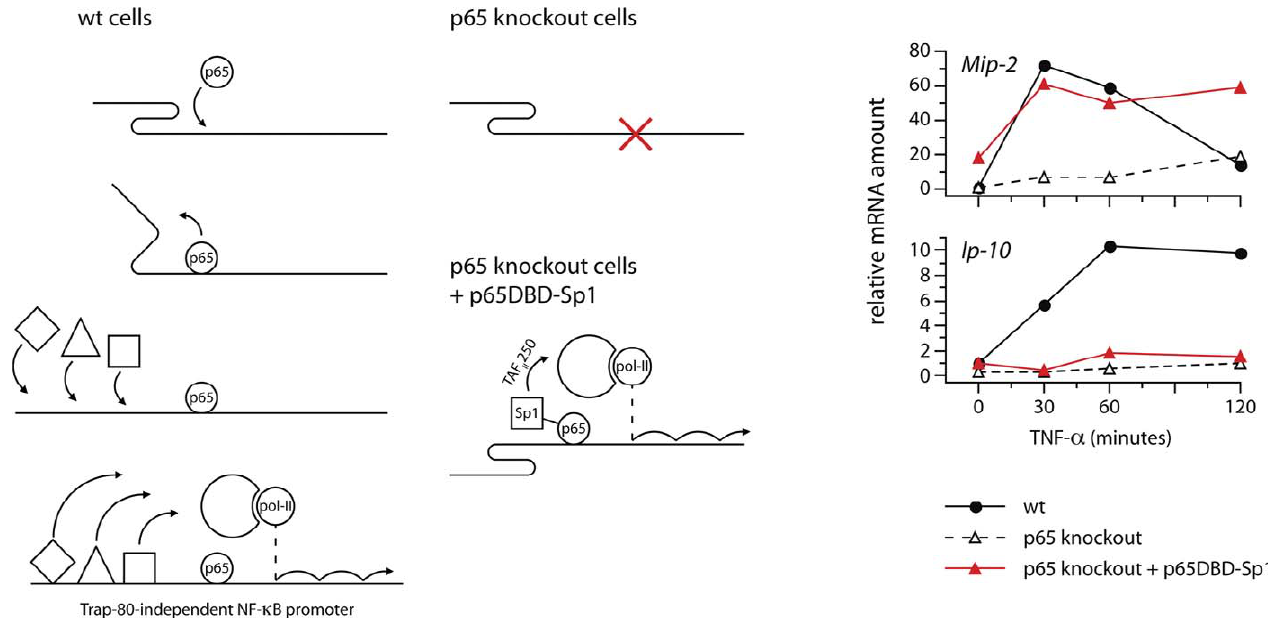
Figure 7. An Artificially Recruited Secondary Transcription Factor Drives Transcription in the Absence of p65 On the left is a cartoon illustrating our model for the events occurring at Trap-80–independent promoters. In wild-type cells, initial p65 binding brings about an undefined change to target promoters, which allows the binding of various secondary transcription factors. Once bound, these can drive the recruitment of pol-II, and so enable transcription. In p65-knockout cells, secondary transcription factors cannot bind and no transcription takes place. If binding of a secondary transcription factor is artificially restored (in this case Sp1), transcription is rescued at promoters that can recruit the relevant co- factors (in this case TAF II 250). On the right, p65-knockout cells were transduced with a retrovirus expressing a fusion of the p65 DBD with the Sp1 TAD (red triangles, p65DBD-Sp1), and expression of Mip-2 and Ip-10 mRNA was compared to untransduced wild-type and p65-knockout fibroblasts. The result is representative of three